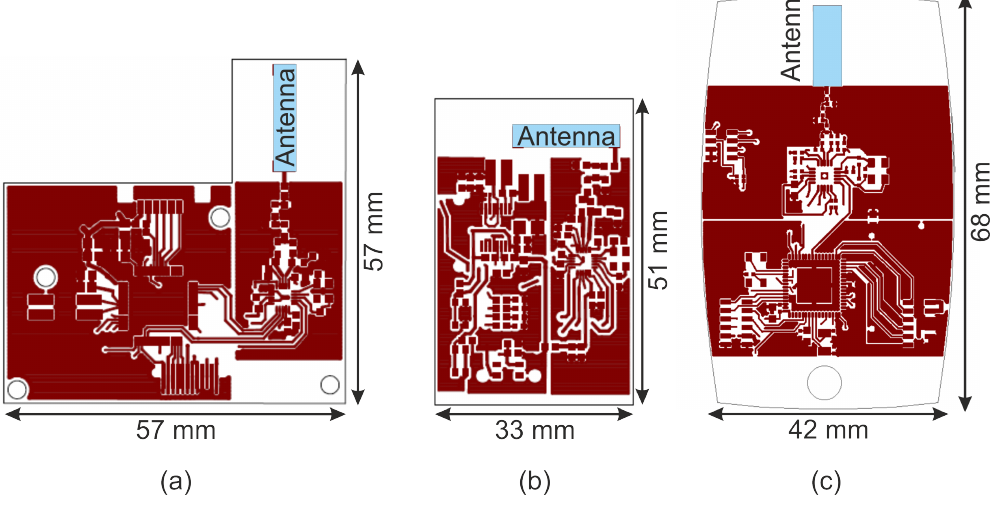
Figure 2. Drawing showing the difference in size between ( a ) the MedIT BSN; ( b ) the IPANEMA BSN nodes generation 2 and ( c ) generation 2.5. Both IPANEMA 2 and 2.5 fit into the same housing.